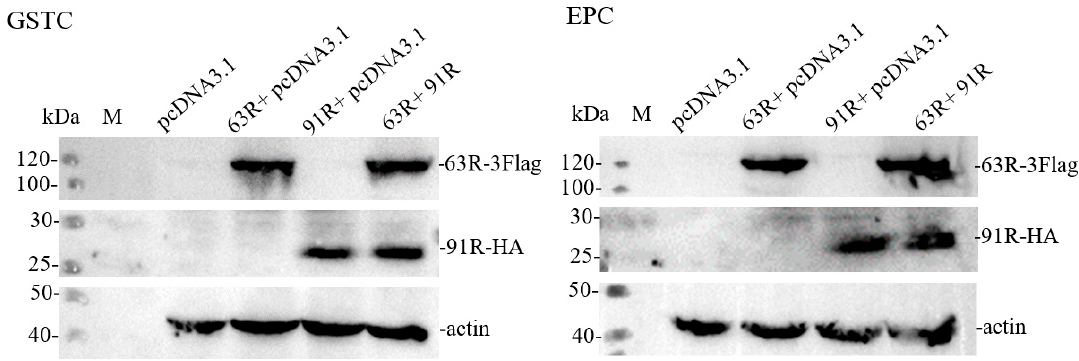
Figure 4. Western blot analysis of protein samples from cells transfected with plasmids for 24 h using anti-Flag and anti-HA. GSTC: in GSTCs expressing protein RGV-63R (63R + pcDNA3.1) or RGV-91R (91R + pcDNA3.1) alone or co-expressing two proteins RGV-63R and RGV-91R (63R + 91R), respectively. EPC: in EPCs expressing protein RGV-63R (63R + pcDNA3.1) or RGV-91R (91R + pcDNA3.1) alone or co-expressing two proteins RGV-63R and RGV-91R (63R + 91R), respectively. The empty vector pcDNA3.1 was used as a control. M: protein molecular mass marker.